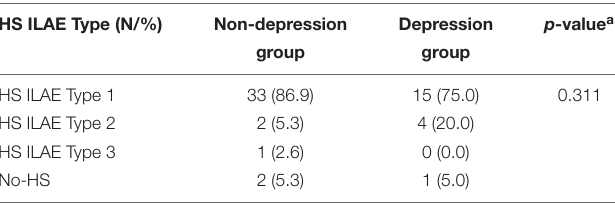
TABLE 4 | Histopathological classification of the patients evaluated in this series, according to the International League Against Epilepsy (ILAE) criteria for the definition of the hippocampal sclerosis type.